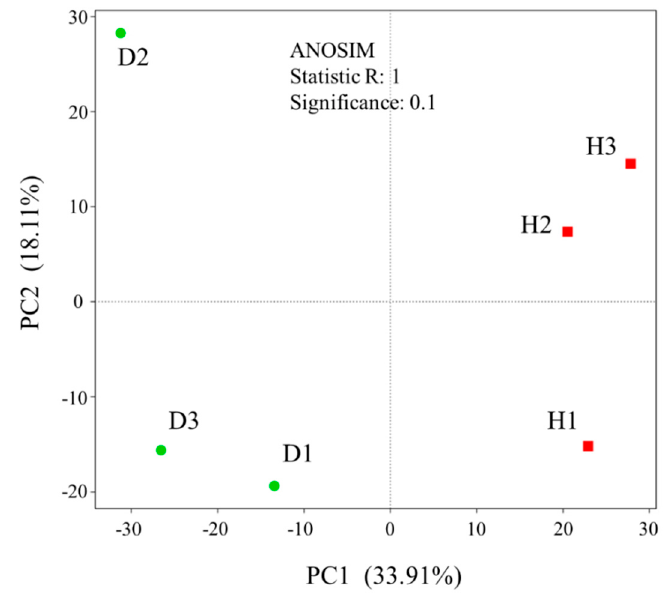
Figure 3. Principal component analysis (PCA) of bacterial community beta-diversity based on Bray–Curtis dissimilarity among all samples of the healthy and diseased roots.